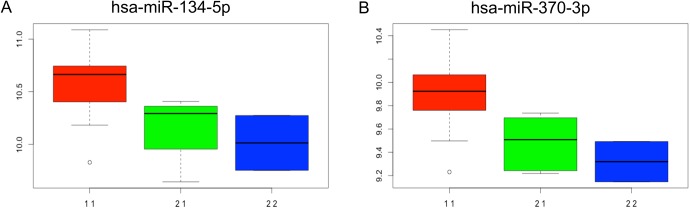
(A). rs11626307 effect on the hsa-miR-134-5p (A) and hsa-miR-370-3p (B) expressions.